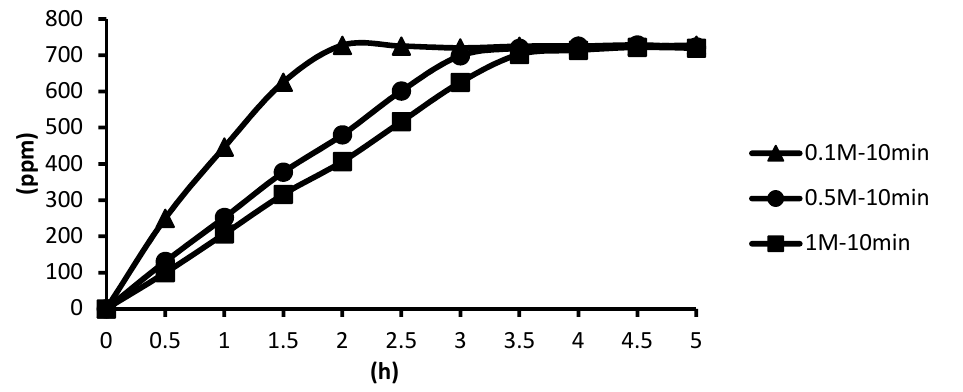
Figure 23. The effect of ZnCl 2 concentration (cross-linking time of ten minutes) on releasing of tea tree essential oil from alginate/tea tree essential oil microcapsules in the hot spring water.